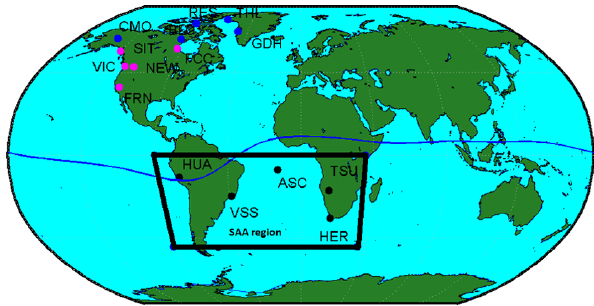
Figure 1. The SAA is situated at an altitude of 200–800km over the Earth’s surface. It extends from 0 to 50 ◦ S and from 90 ◦ W to 40 ◦ E. The black circle is the station in the SAA